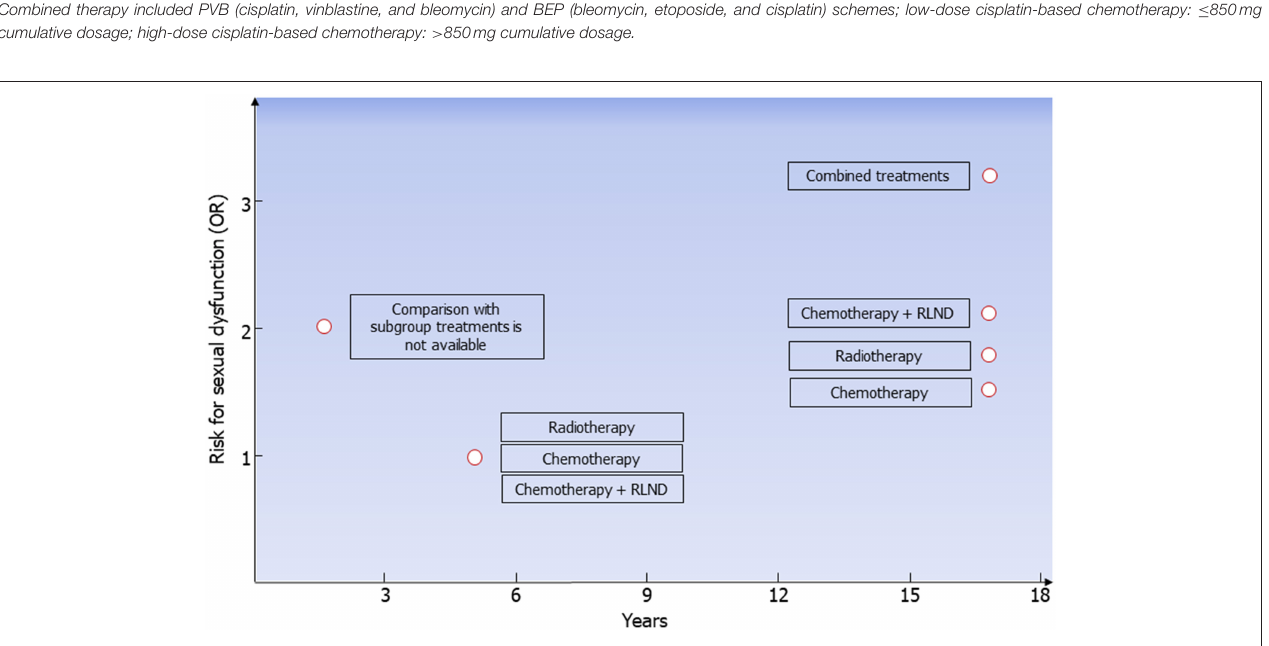
FIGURE 2 | Risk for erectile dysfunction in testicular tumor survivors. According to data coming from all the available follow-up studies, risk for erectile dysfunction (ED) is higher 2 years after treatment in testicular tumor survivors. At the fifth year following radiotherapy, chemotherapy, or chemotherapy plus retroperitoneal lymph node dissection (RLND), the erectile function is apparently restored. The risk for ED is higher in patients treated with chemotherapy (OR 1.5), radiotherapy (OR 1.7), chemotherapy plus RLND (OR 2.1), and combined treatments (OR 3.2) compared to those treated with surgery